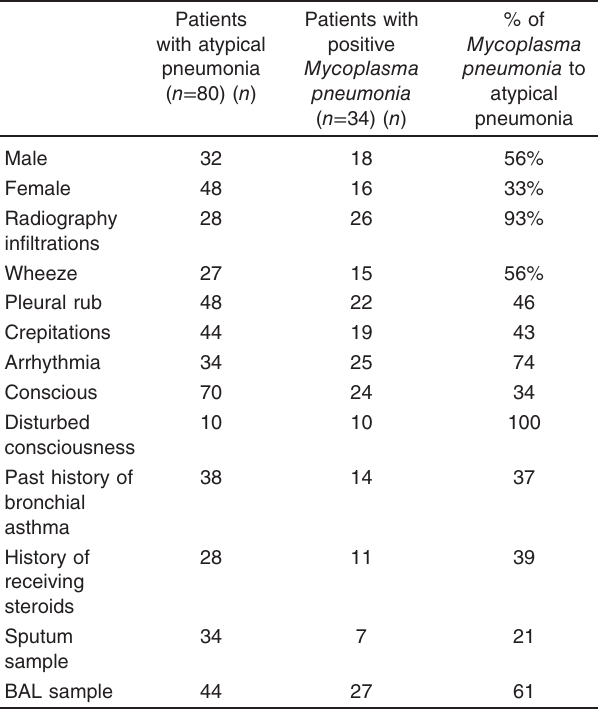
Table 5 Clinical data of Mycoplasma pneumoniae positive group regarding the studied patients Patients with